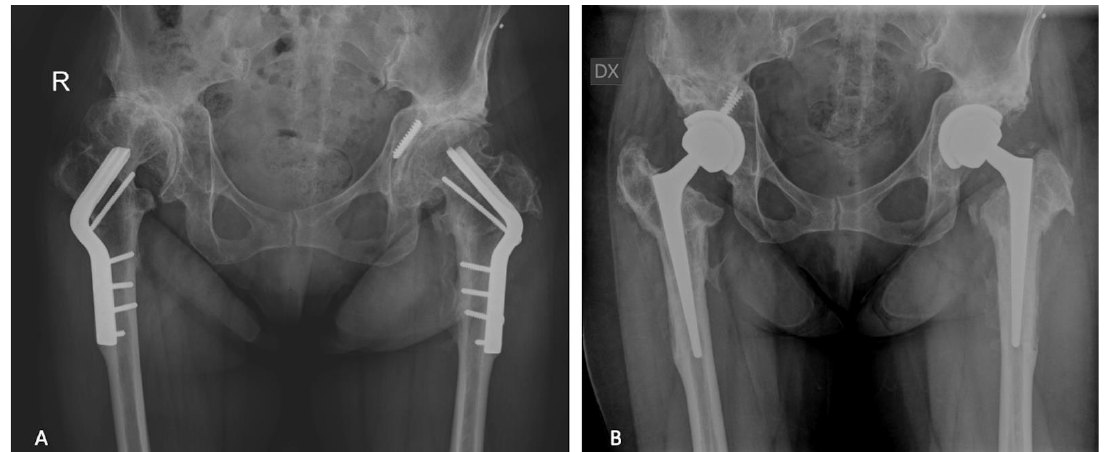
Figure 2. ( A ) Secondary hip osteoarthritis. ( B ) Postoperative Xray after conversion total hip arthro- plasty with monoblock conical stem. ( C ) Stem subsidence at 3 days postoperatively treated with stem revision. R means right. ( D ) Early revision with long revision conical stem.